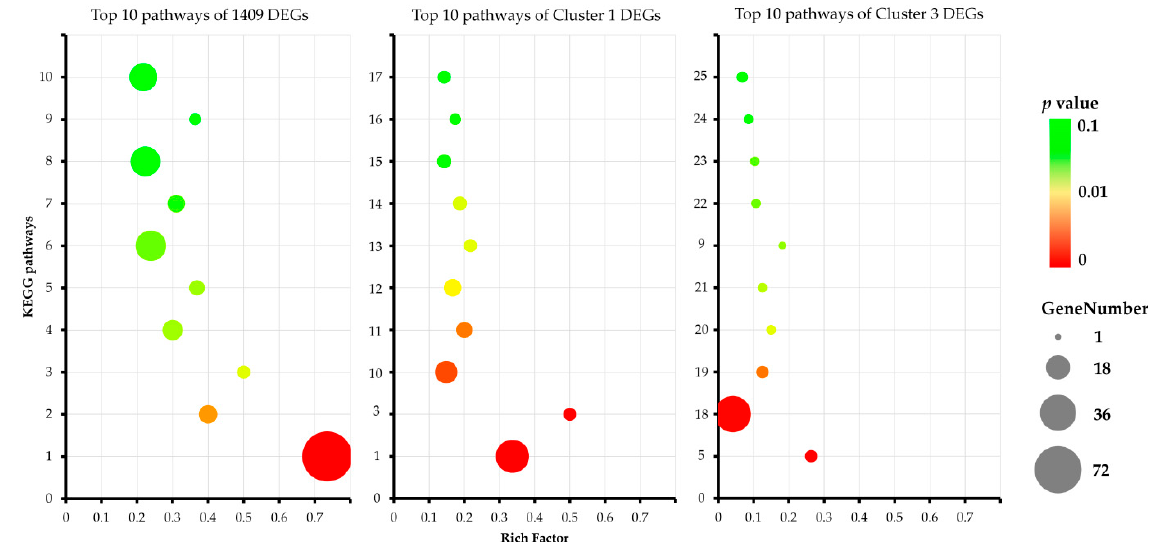
Figure 8. Bubble diagrams of top 10 enriched KEGG pathways of among different groups. Numbers on Y-axis represent KEGG pathways: 1. ribosome; 2. pentose phosphate pathway; 3. fatty acid elon-